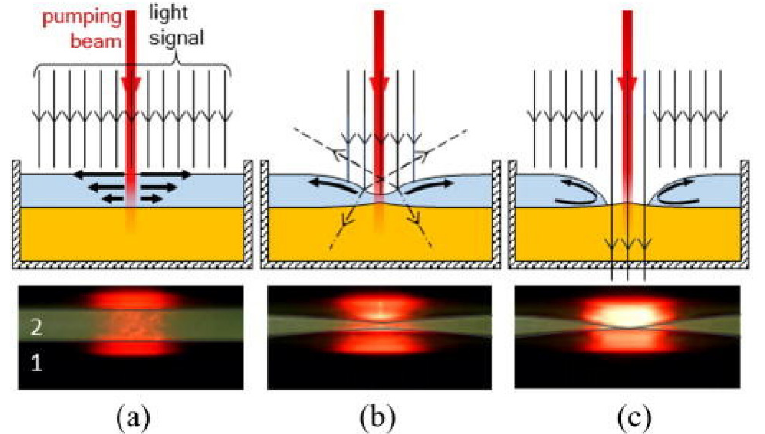
Figure 34. Schematic diagram of the working mechanism. ( a ) The thermocapillary flow rises in the upper layer. ( b ) The thermocapillary deformation of the upper layer and the convex deformation of the bottom layer. ( c ) The upper thermocapillary rupture [139]. Reprinted with permission from Ref. [139]. 2019 AIP Publishing.